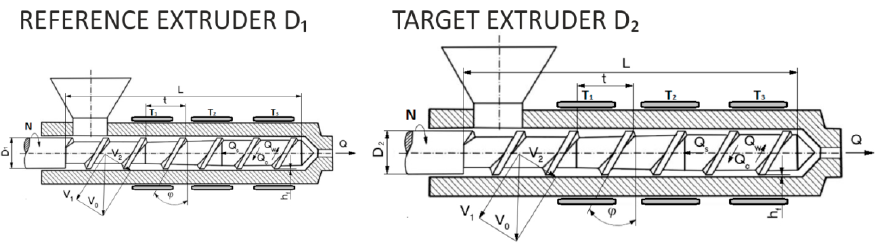
Figure 2. The concept of scaling-up for polymer extrusion: D 1 —reference screw diameter, D 2 —target screw diameter.